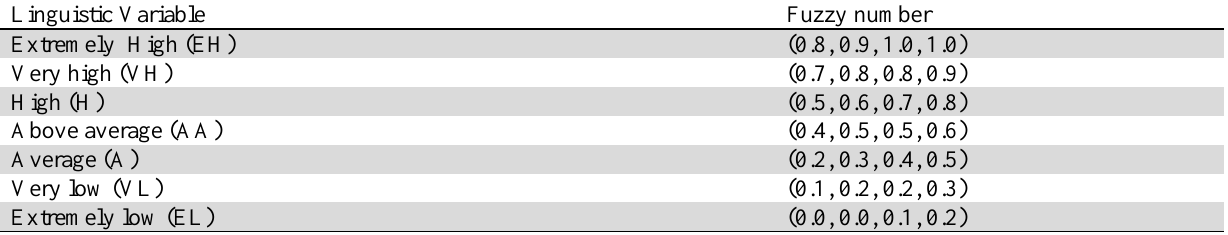
Linguistic Variable